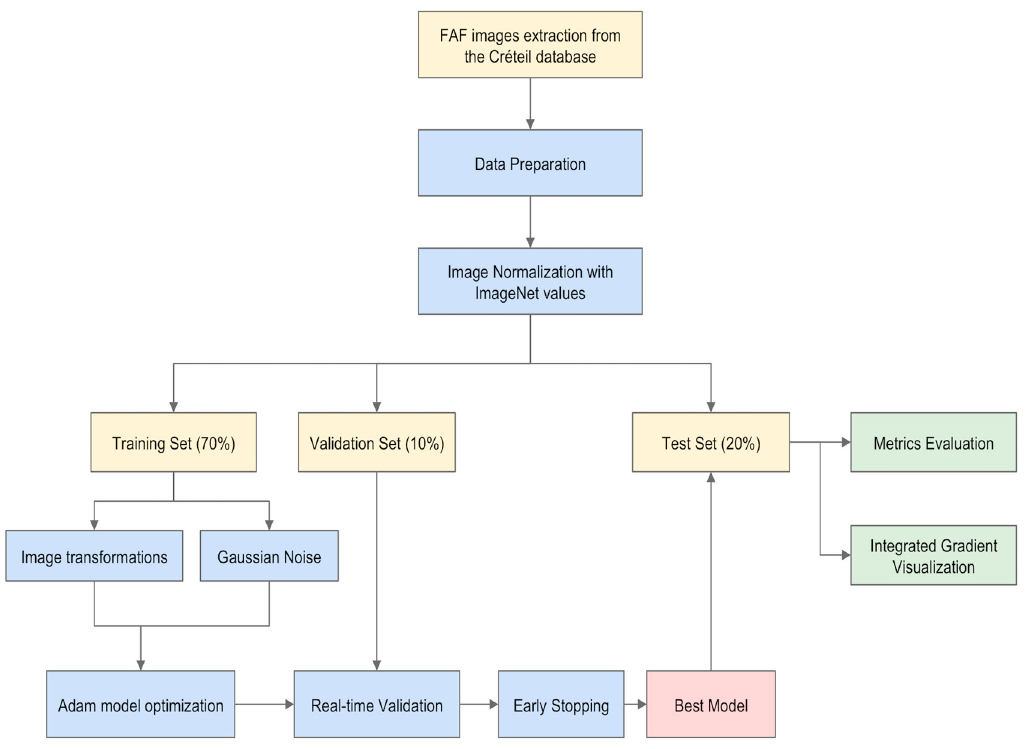
Figure 1. Illustration of the development of a deep learning classifier: fundus autofluorescence images of Stargardt disease, retinitis pigmentosa, and Best vitelliform macular dystrophy as well as of healthy controls were extracted from the Créteil database. After data preparation, transfer learning from the ImageNet dataset (http://www.image-net.org/) was used. The images were randomly partitioned in three sets: the training set (70% of the images), the validation set (10% of the images), and the test set (20% of the images). Data augmentation was performed on the training set to increase the original dataset and to reduce overfitting of the final model. The images were normalized using the mean and standard deviation of the ImageNet dataset to match the model initialization. The model was optimized using Adam Optimization Algorithm during 5000 iterations. The model was then evaluated with the test set of 94 images. The output of the model was the metric evaluation of the performance of the model (accuracy, sensitivity, and specificity) and integrated gradient visualization.